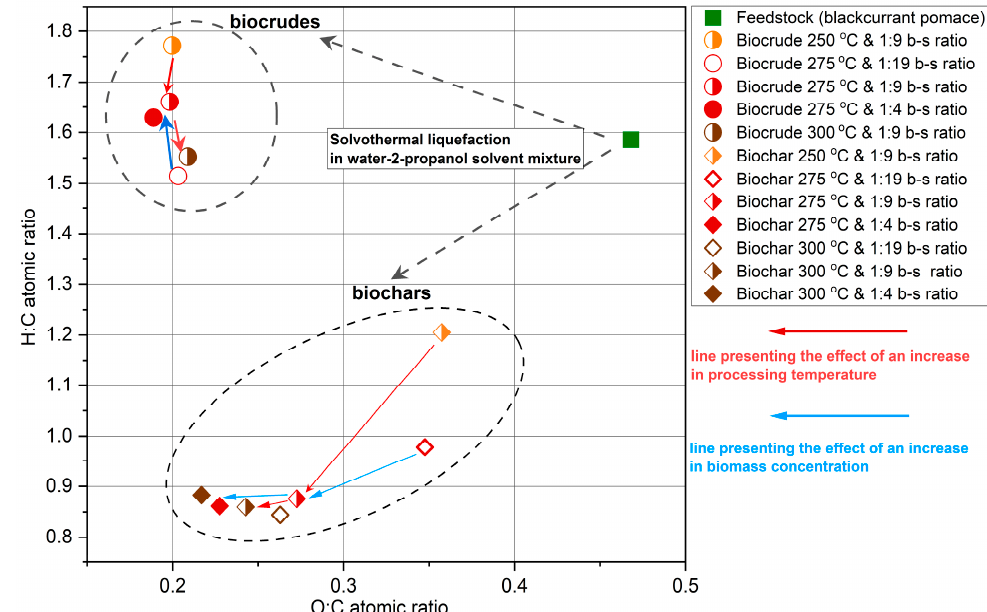
Figure 3. Van Krevelen diagram for biocrudes obtained from blackcurrant pomace at different pro- cessing conditions . processing